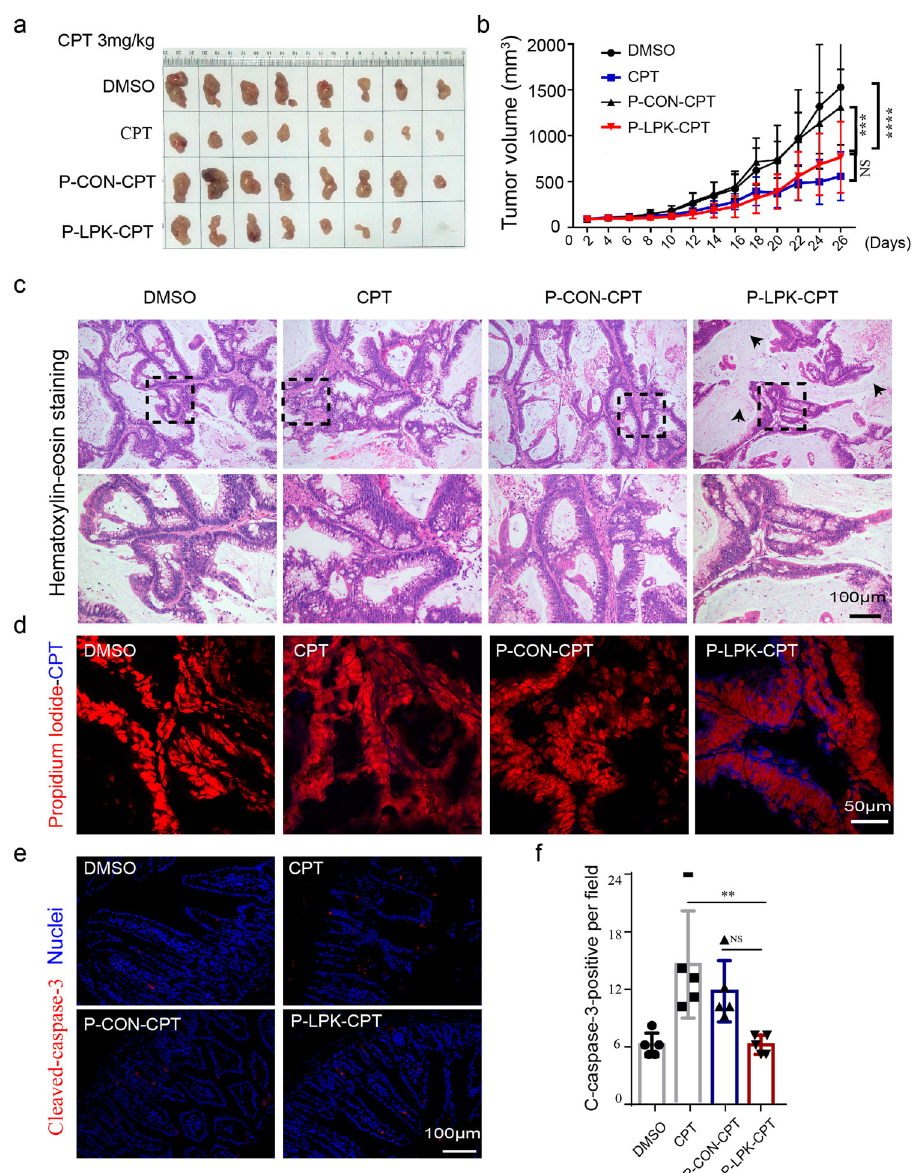
Fig. 4 In vivo antitumor effects of P-LPK-CPT in CRC patient-derived xenografts. a , b The size of tumors of different treatments after 26 days. Tumor volume changed after intravenous injection of the P-LPK-CPT conjugate ( n = 8, means ± SD) (*** p < 0.001, **** p < 0.0001). c HE staining showed that the tumor tissues of the P-LPK-CPT group were substantially replaced by connective tissues (arrowheads). d CPT signal (blue dots) was much stronger in the P-LPK-CPT tumor tissues. Red color was from propidium iodide (PI) for nuclear visualization. e , f Representative images ( e ) and quanti fi cation ( f ) of Cleaved caspase 3 immuno fl uorescence in colon tissues ( n = 5, means± SD) (CPT vs P-LPK-CPT, p = 0.0051; P-CON-CPT vs P-LPK-CPT, p = 0.0722; ** p <